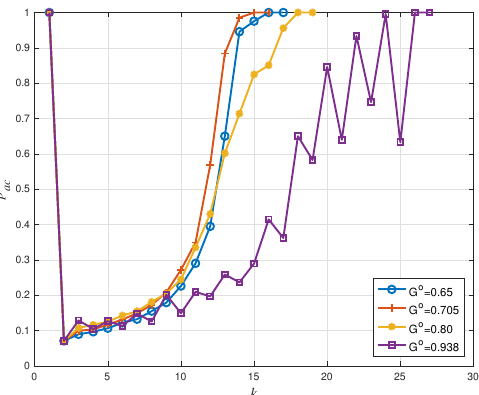
Figure 6. Access probability p ac versus frame index k for IRSA with Λ ( x ) = 0.5 x 2 + 0.28 x 3 + 0.22 x 8 .